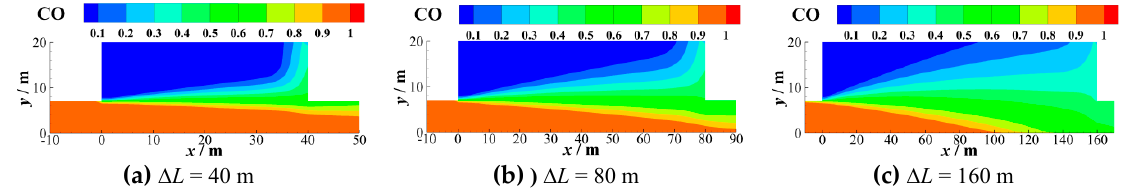
Figure 8. Distribution of CO concentration in the longitudinal section at different ∆ L / D.